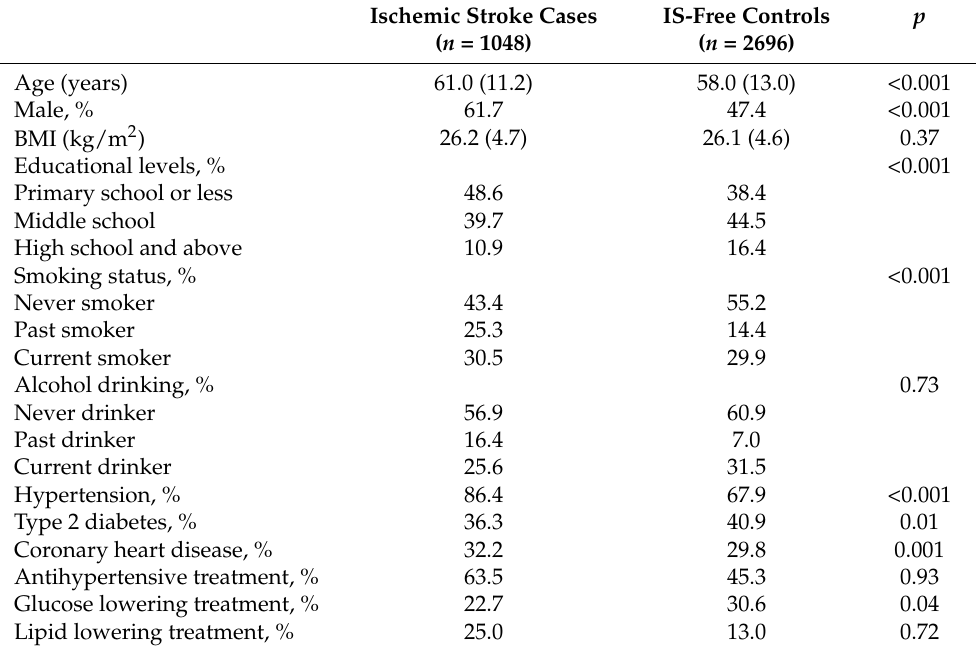
Table 1. Baseline characteristics of participants according to ischemic stroke status at baseline. Ischemic Stroke Cases IS-Free Controls p ( n =